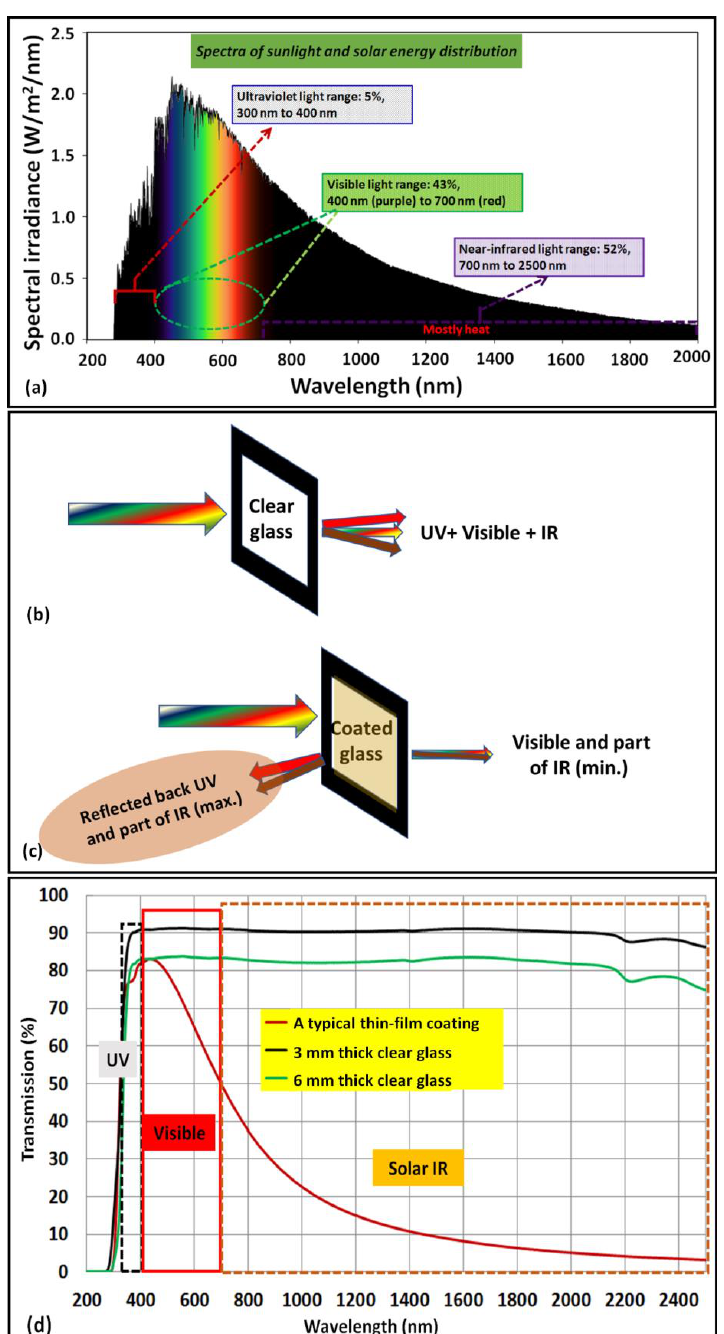
Figure 6. The spectra of sunlight and solar energy distribution ( a ), the features of sunlight spectra before and after passing through a clear glass and low-E thin-film-coated glass ( b , c ), and the meas- ured transmission spectra of a laboratory-demonstrated typical thin-film coating compared with 3 and 6 mm clear glass panels ( d ). It can be seen that the thin-film coating significantly filters the solar IR spectrum while clear glass transmits most of the IR spectrum.